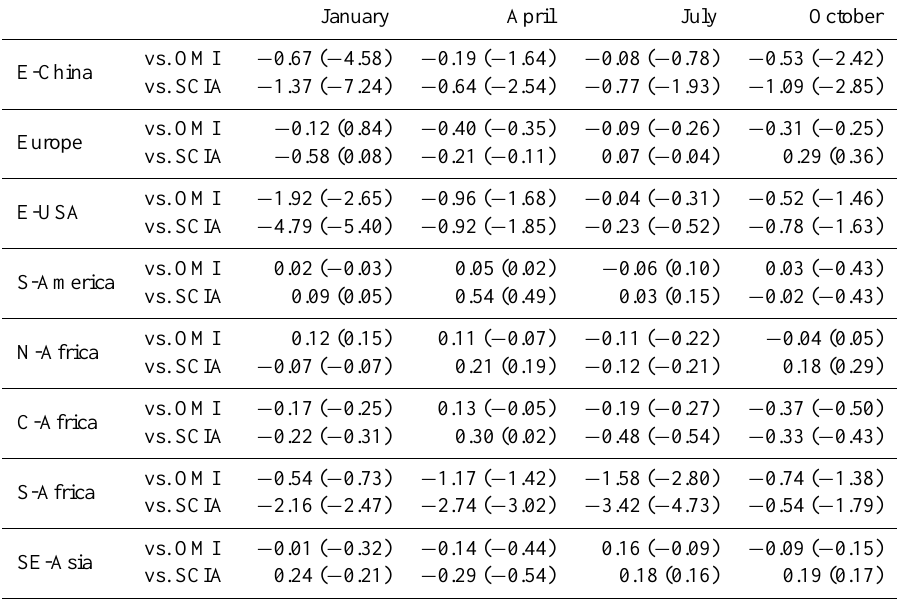
Table 5. The 15-days mean (averaged over the 16–30th of each month) bias of regional mean tropospheric NO 2 columns; the data assimila- tion run minus the satellite retrievals (DOMINO v2 (OMI) and SCIAMACHY (SCIA)) in 10 15 molec . cm − 2 , for four months in 2005. The model simulation results (without data assimilation) are also shown in